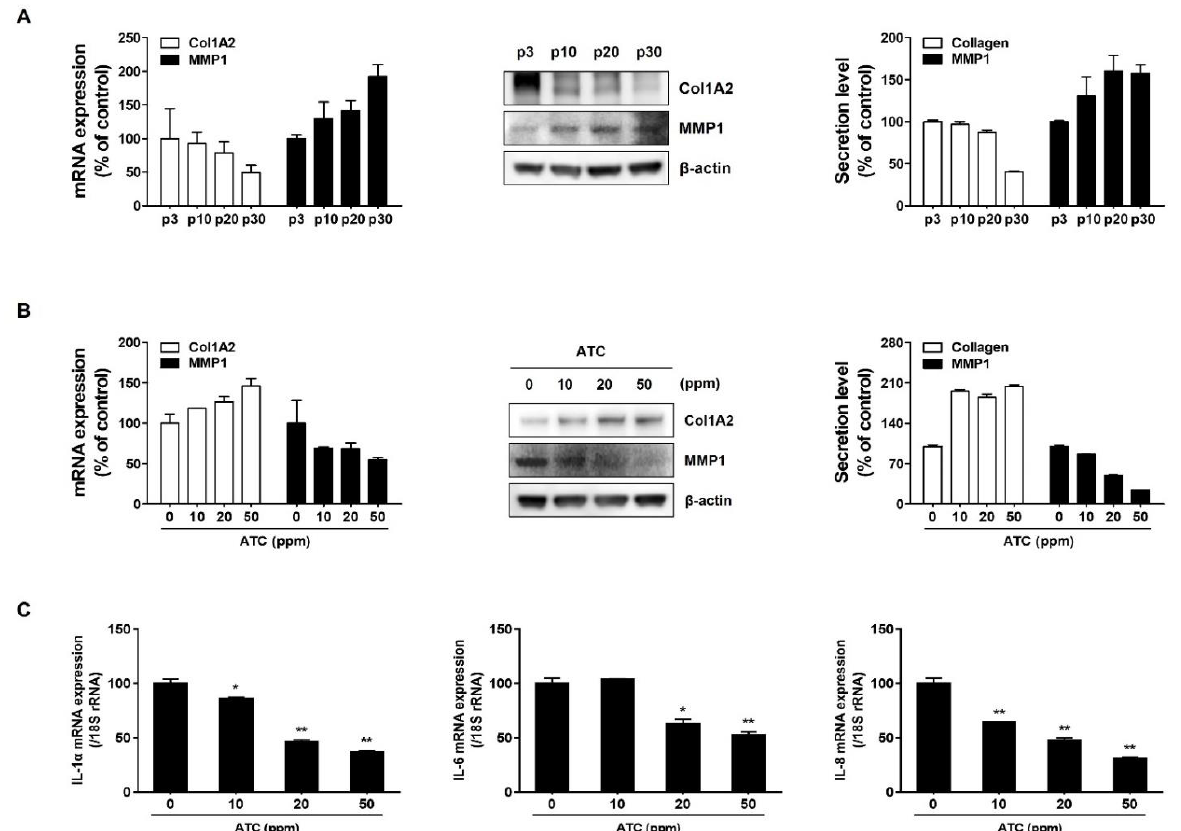
Figure 4. ATC regulates ECM related gene expression and SASP in senescent fibroblasts. ( A ) Representative expression of ECM related genes MMP1 and Collagen according to passage number was confirmed at RNA level, protein expression, and secretion. ( B ) Expression of ECM related genes MMP1 and Collagen after treatment with indicated concentration of ATC was confirmed at RNA level, protein expression, and secretion. ( C ) Representative expression of SASP related genes IL-1α, IL-6, and IL-8 according to passage number was confirmed at RNA level. Data are presented as mean ± SD of three independent assays. *, p < 0.05; **, p < 0.01 compared to control.